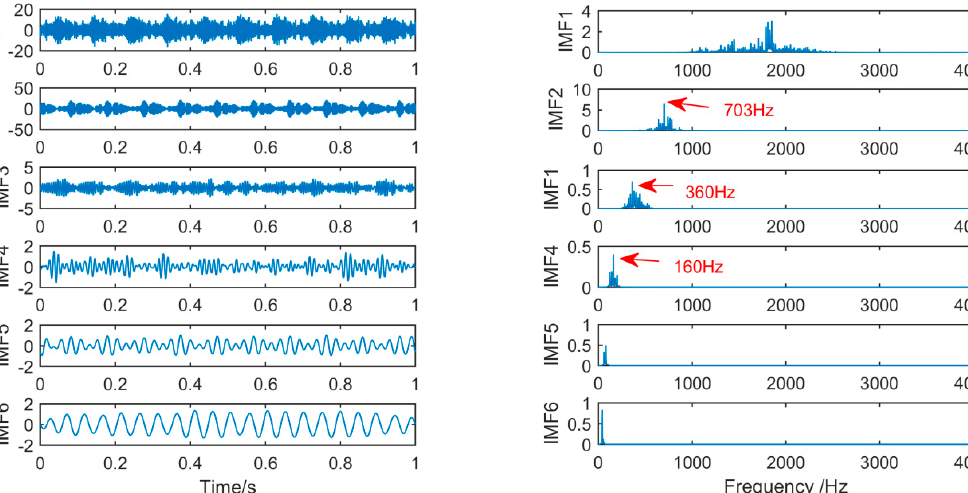
Figure 17. The spectrum of IMFs after SSD decomposition and its corresponding spectrum.